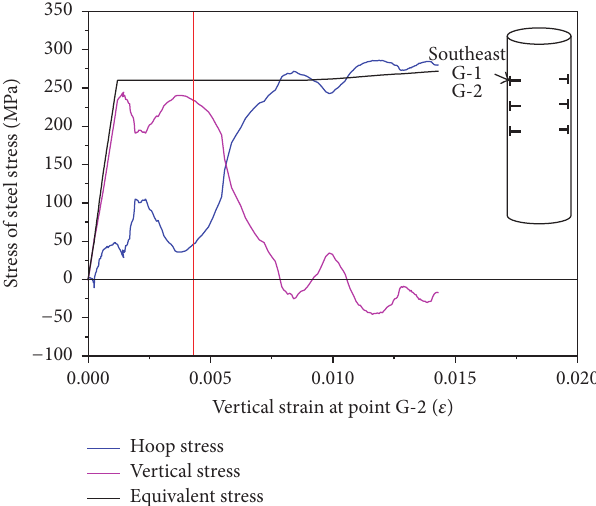
Figure 8: Stress-strain relationship of steel tube at gauge points G-1 and G-2.